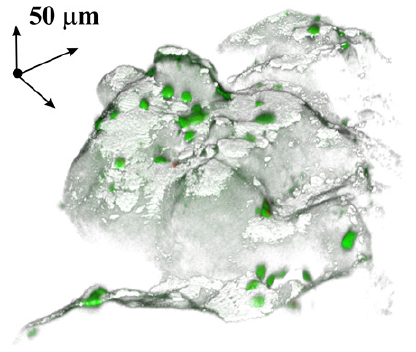
Figure 8. CLSM image of sample TN after cell growth for one week. Green color is used for visualization of grown MCF-7 cells.